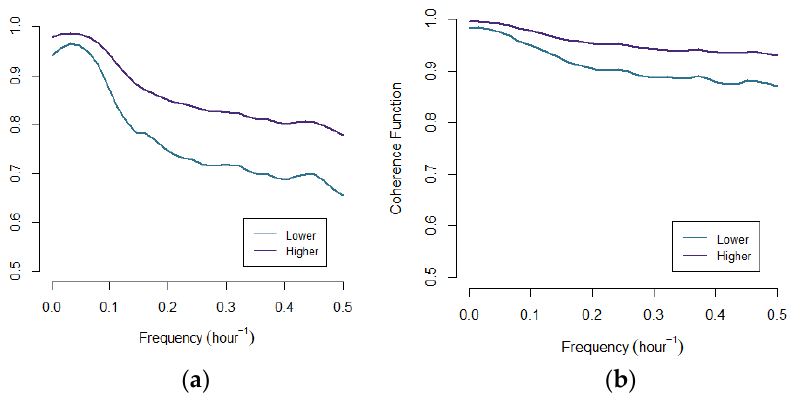
Figure 5. Mean coherence profile for the ( a ) solar radiation and ( b ) air temperature. Blue line represents the mean coherence profile of the lower median agreement months, while the purple line shows the mean coherence profile for the remaining months.